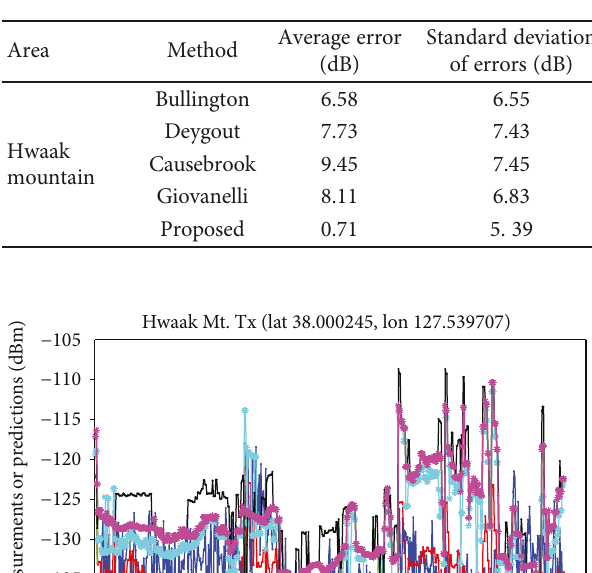
Table 2: Comparison in the area where data are not used in training (Mt. Hwaak).